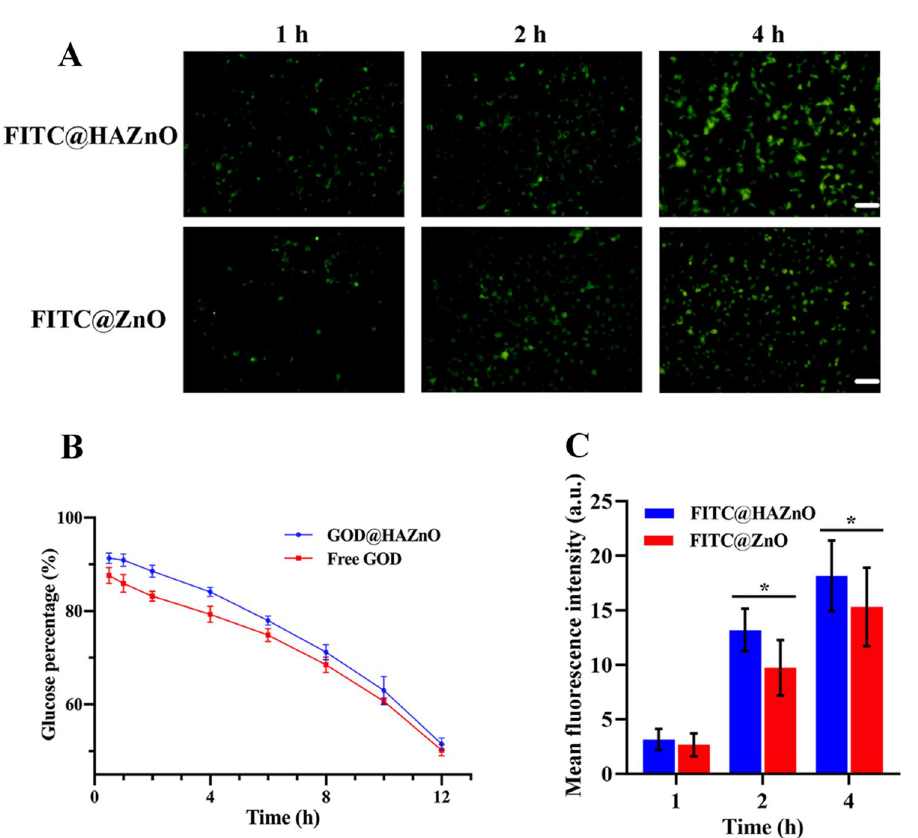
Figure 4. ( A ) Fluorescence images of 4T1 cells represent the intracellular uptake at 1, 2, and 4 h, respectively; ( B ) The remaining glucose percentage after co-incubated with GOD@ZnO or free GOD; ( C ) The semiquantitative analysis: mean fluorescence intensity of images in ( A ). Data are presented as mean ± SD, n =